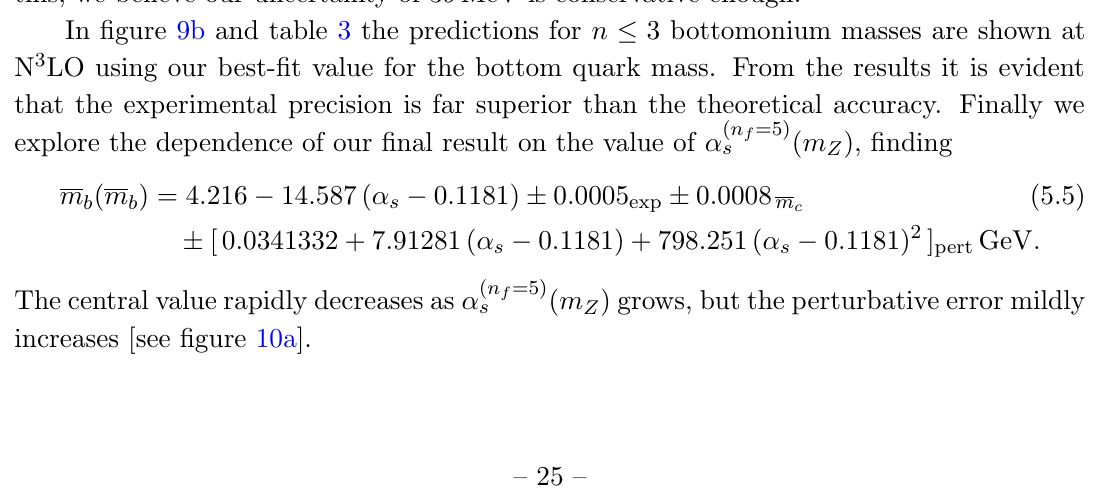
Table 1. Results for m b (cid:12)ts for di(cid:11)erent set of states in the MSRn scheme at N rows correspond to (cid:12)ts to individual states, whereas the last 6 rows show global (cid:12)t results. Columns 2 to 6 and 7 to 11 show the (cid:11) ( n ‘ =4) s and (cid:11) ( n ‘ =3) s schemes, respectively. Within each (cid:13)avor-scheme block, the uncertainty is split in columns second to (cid:12)fth into experimental, perturbative, due to uncertainty in (cid:11) ( n f =5) s ( m Z ) and due to uncertainty in m c ( m c ), respectively. For the various global (cid:12)ts the error associated to the experimental uncertainty (that is, the error coming from the (cid:12)t) is p rescaled by the factor (cid:31) 2 = d : o : f : All masses and errors are expressed in min